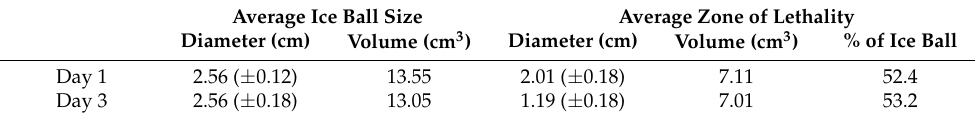
Figure 1. Assessment of cell death following cryoablation using a PaCa TEM. ( A ) Fluorescent micrograph of the PANC-1 TEMs following single 5 min freeze. At 24 h post-freeze, TEMs were probed with calcein-AM (green, live) and propidium iodide (red, dead) and visualized using fluorescent microscopy to determine the extent of cell death. Isotherms were extrapolated from thermal monitoring and imprinted onto images for assessment. The blue line represents the edge of the iceball and the orange line represents the edge of necrotic cell death. ( B ) Real-time monitoring of the isothermal profile generated by the PSN 1.5 mm cryoprobe at the center of the ablation segment within a TEM during a 5-min freezing protocol. Temperatures of the bath (“media”) and within the TEM were monitored throughout the freezing process at the midpoint of the freeze zone using a type-T multipoint thermocouple array at fixed distances extending radially from the surface of the cryoprobe. ( C ) Actual distances were measured using Zen software from images acquired from the visualized thermocouples within each TEM layer. ( D ) Isotherms (0 °C, −1 0 °C, −2 0 °C −3 0 °C, −4 0 °C) were extrapolated from measured data points. Table 1. Analysis of ice ball size and lethality following freezing.